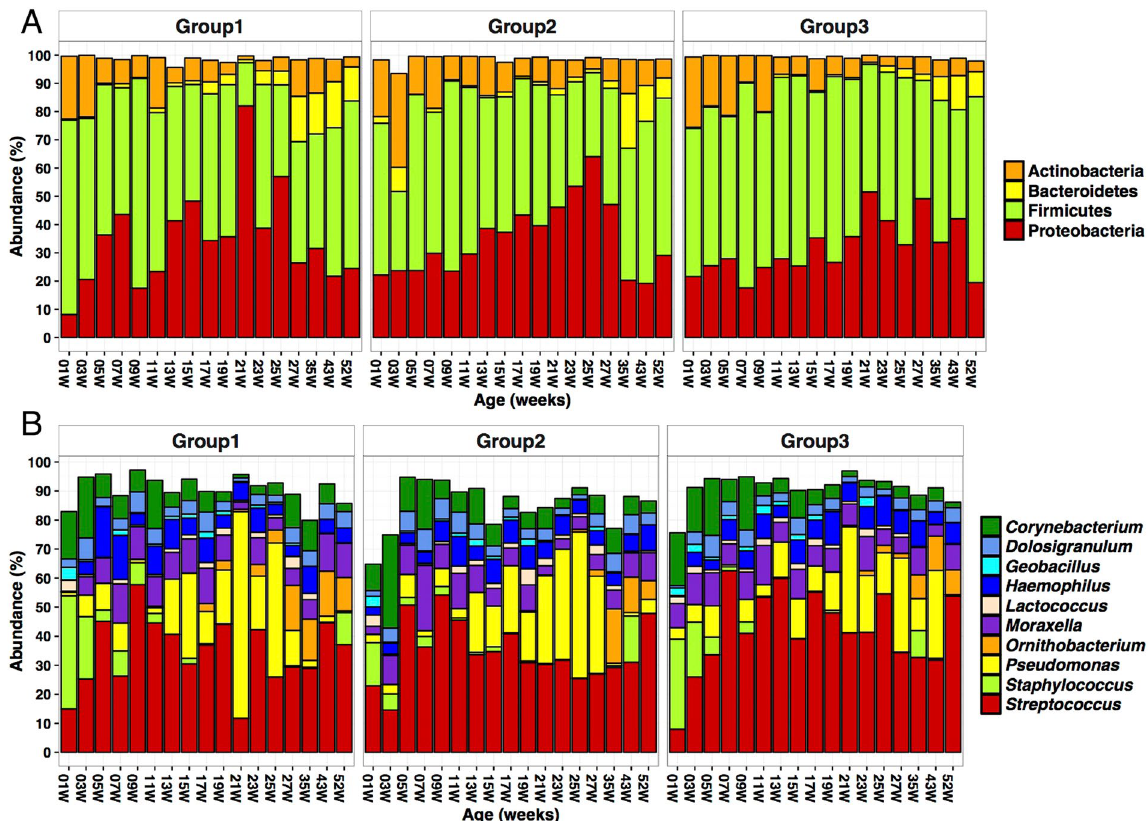
Figure 3. Composition of the nasopharyngeal microbiome in the first year of life. The distribution of the top 5 phyla ( A ) and the top 10 genera ( B ) in the nasopharyngeal microbiome from birth to 52 weeks for each vaccination group is